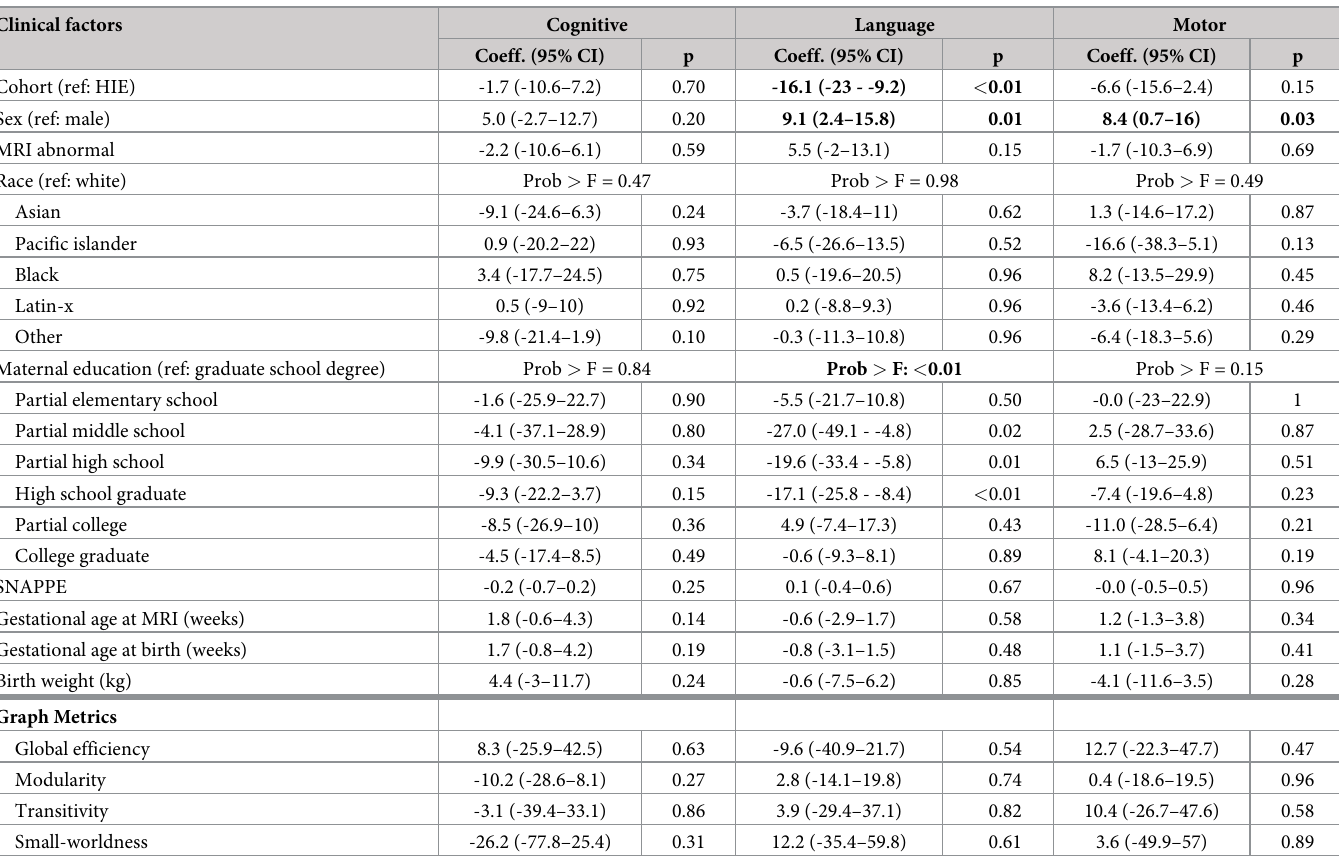
Table 3. Univariate analysis of 12-18-month neurodevelopmental